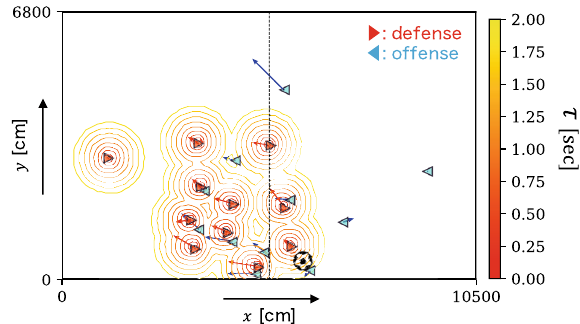
Figure 1. Visualization of τ df at a certain time as a contour plot over a range of 2 s. Players in offense (i.e., ball possession team) and defense teams are depicted using blue leftward and red rightward triangles, respectively. In this situation, the player on the right side near the halfway line has the ball and is trying to pass it to the other side.